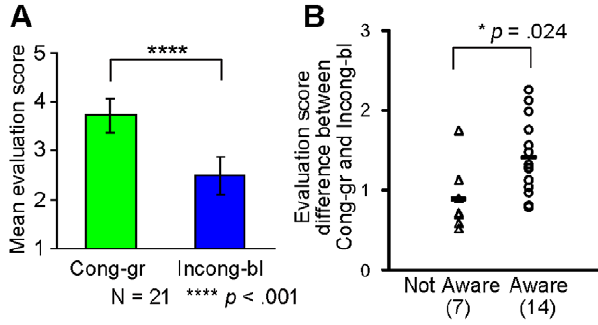
Figure 2. Action evaluation of one’s own motor behavior. (A) Mean evaluation scores in the congruent-green and incongruent-blue conditions of the practice phase. Error bars indicate the SDs of the evaluation scores between participants. (B) Difference of evaluation scores between the congruent-green and incongruent-blue conditions of the practice phase. Triangles denote the data for each participant of the ‘‘not aware’’ group, those who did not report an association between their own performance and the color cue. Circles denote that of the ‘‘aware’’ group, those who reported an association between their own performance and the color cue.